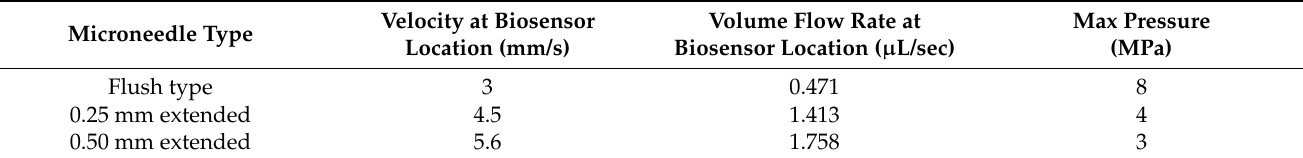
Table 2. Summary of pressure and velocity in the micropump